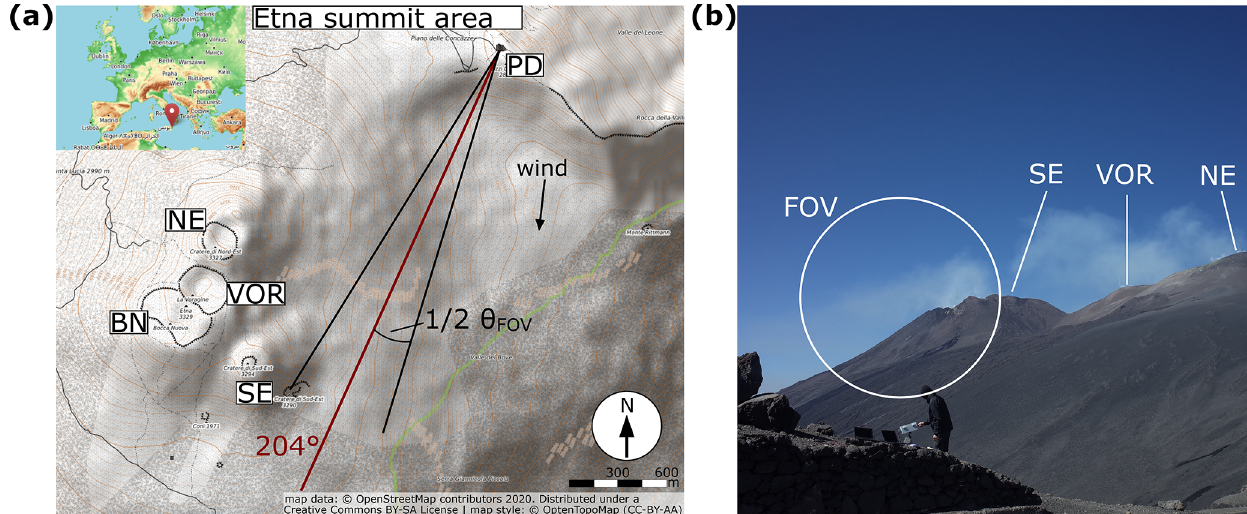
Figure 5. (a) Topographic map of the Mt. Etna summit area: North-East Crater (NE), Voragine (VOR), Bocca Nuova (BN), South-East Crater (SE), and measurement location at the Osservatorio Vulcanologico Pizzi Deneri (PD) are indicated. The viewing direction on 22 July 2019 is 204 ◦ (red drawn) with a FOV of θ FOV = 18 ◦ (black drawn) and an elevation of 5 ◦ . The FOV is partly covering the plume emanating from SE crater. The average wind direction is ≈ 5 ◦ with a speed of ≈ 6ms − 1 (wind data from UWYO, 2020). (b) Visual image of the volcanic plume on 22 July 2019 with camera field of view (FOV) indicated.